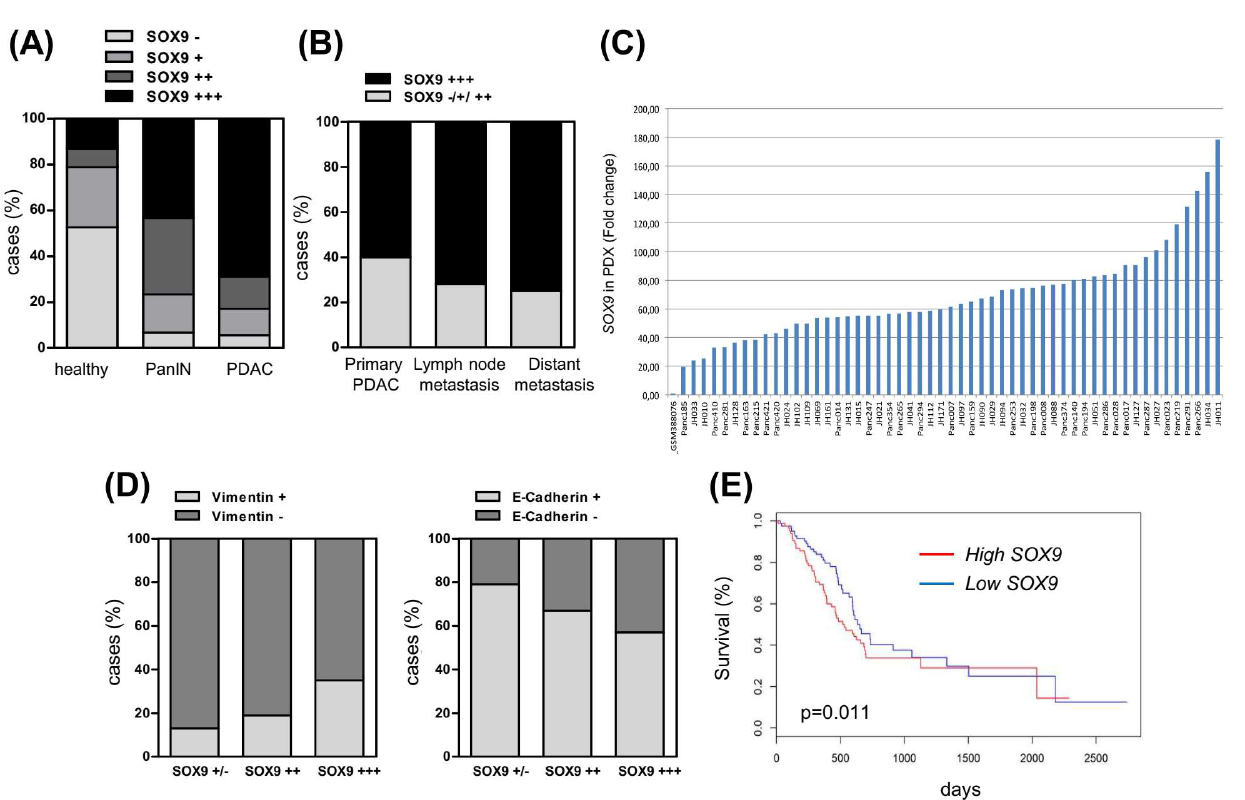
Figure 8. High levels of SOX9 are associated with PDAC progression and reduced survival. ( A ) SOX9 intensity analyzed by immunohistochemistry in a tissue microarray (TMA) composed by human samples of healthy pancreas ( n = 38), PanIN ( n = 30) and PDAC ( n = 198). (-): 0–20 intensity grade; (+): 30–50 intensity grade; (++): 60–80 intensity grade; (+++): 90–100 intensity grade. ( B ) Distribution of SOX9 expression analyzed by immunochemistry in PDAC samples according to stage. Primary PDAC ( n = 58), lymph node metastases ( n = 123) and distant metastases ( n = 12). ( C ) SOX9 mRNA expression in 53 pancreatic tumors from patient-derived xenografts (PDXs) relative to the average SOX9 expression level found in 36 samples of normal human pancreas. Expression in normal tissue is included as first line (GSM388076), whereas the remaining lines are the independent PDXs with the respective number in the bottom. ( D ) Negative association between SOX9 and vimentin protein expression (chi square, p = 0.0006) and positive association between SOX9 and E-Cadherin expression (chi square, p = 0.003) in human PDAC. Data obtained by immunohistochemistry in the TMA of 198 human PDAC samples. ( E ) Overall survival analysis of pancreatic cancer patients from the TCGA cohort according to SOX9 expression ( p = 0.011, n = 178).